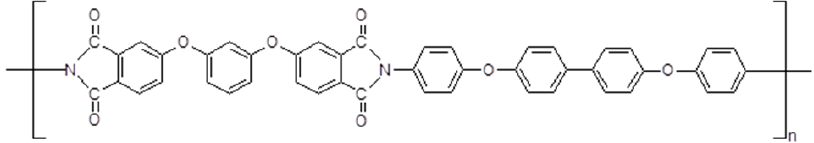
Figure 1. The chemical structure of the polyimide R-BAPB repeating unit.